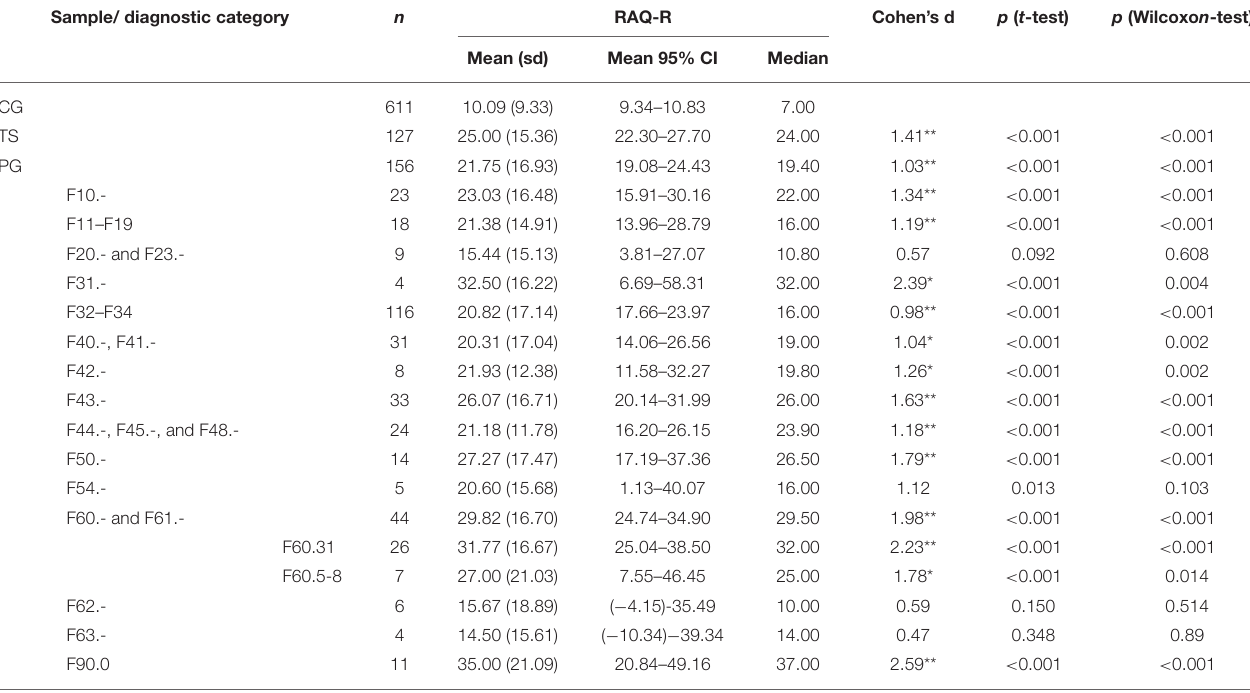
TABLE 3 | RAQ-R scores in controls (CG) compared to patients with Tourette syndrome (TS), the mixed psychiatric sample (PG), and diagnostic categories according to ICD-10 with n > 1. Sample/ diagnostic category n RAQ-R Cohen’s